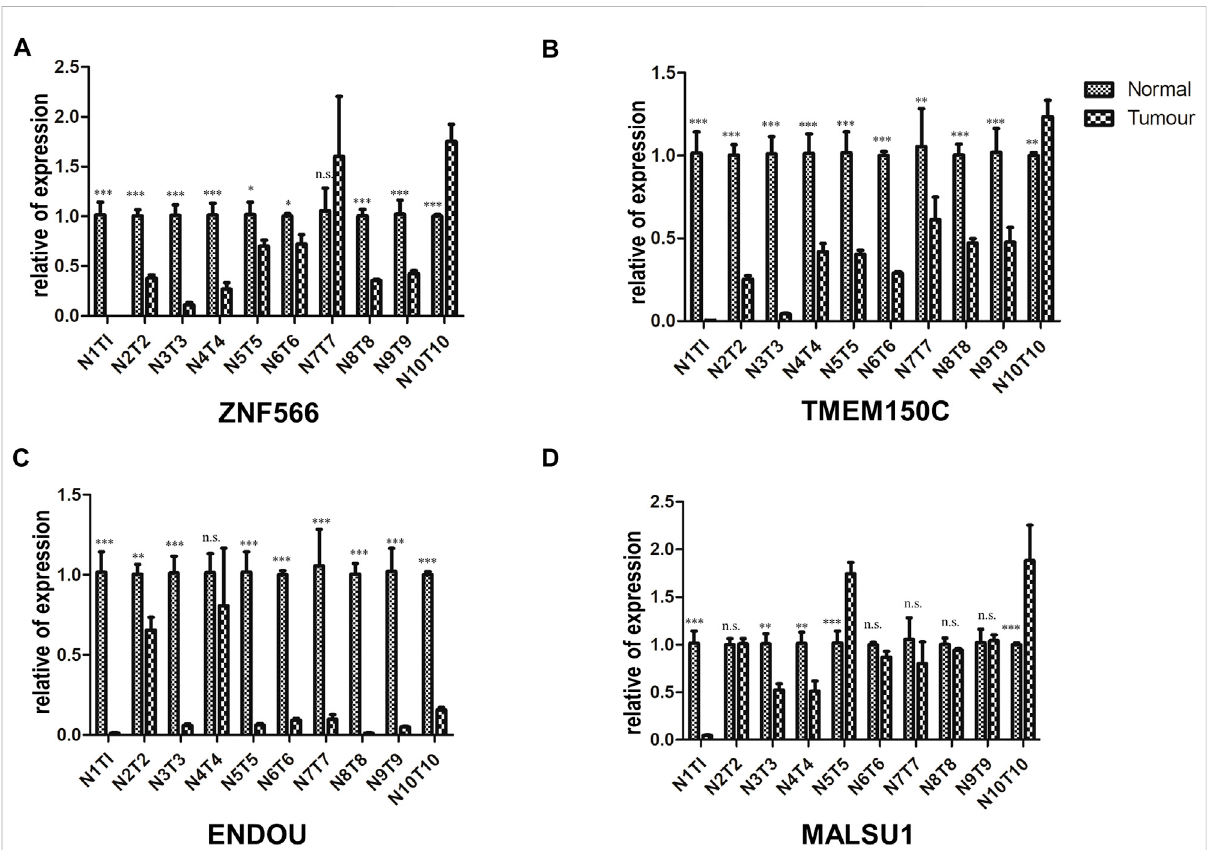
FIGURE 13 Validationofthe4ferroptosis-relatedgenesinHNSCtissues.RT-qPCRdetectingthemRNAexpressionlevelsof (A) ZNF566, (B) TMEM150C, (C) ENDOU, (D) MALSU1 in the tumor tissue and adjacent tissue of HNSCC patients and normal tissues HNSCC patients* p < 0.05; ** p < 0.01; *** p <